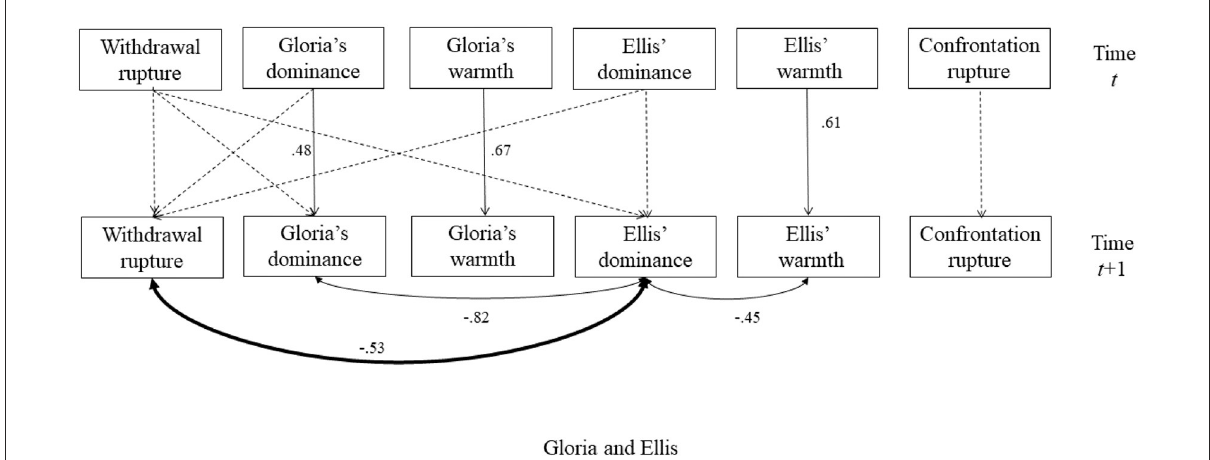
FIGURE6 The selected model for the session with Ellis. The dash lines indicated non-significant autoregressive or cross-lagged regressive pathways. Significant parameters were noted next to solid lines. The double-arrowed lines indicated covariance and the single-arrowed lines indicated autoregressive or cross-lagged regressive pathways. The significant relationships between interpersonal behaviors and ruptures were bolded. The association between Gloria’s dominance and withdrawal ruptures became non-significant ( p = 0.047, 95% CI is − 0.06 to 0.69) after adding the cross-lagged